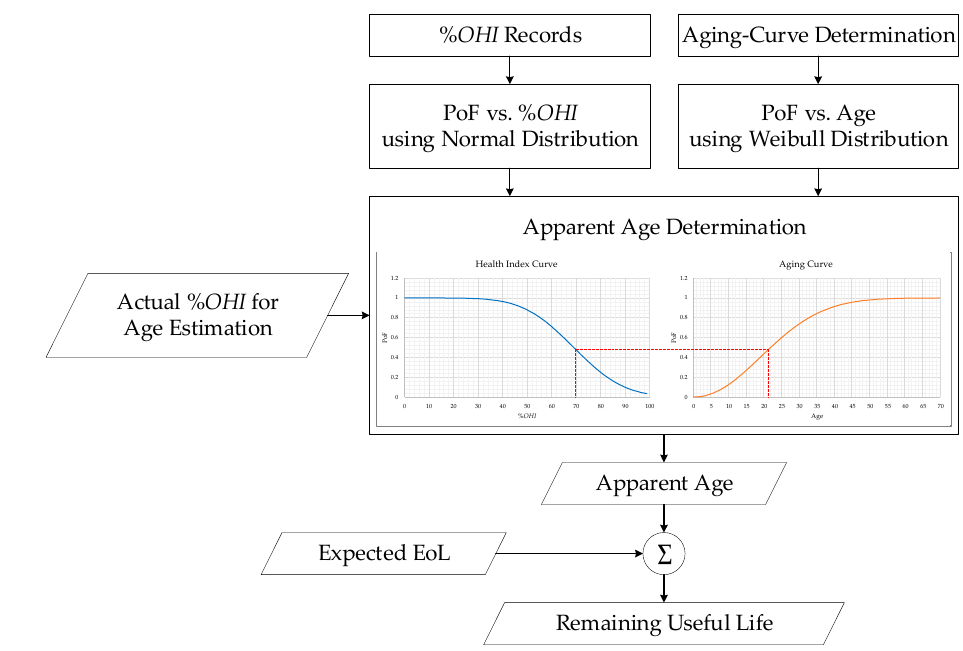
Figure 3. Remaining useful life estimation procedure [26].